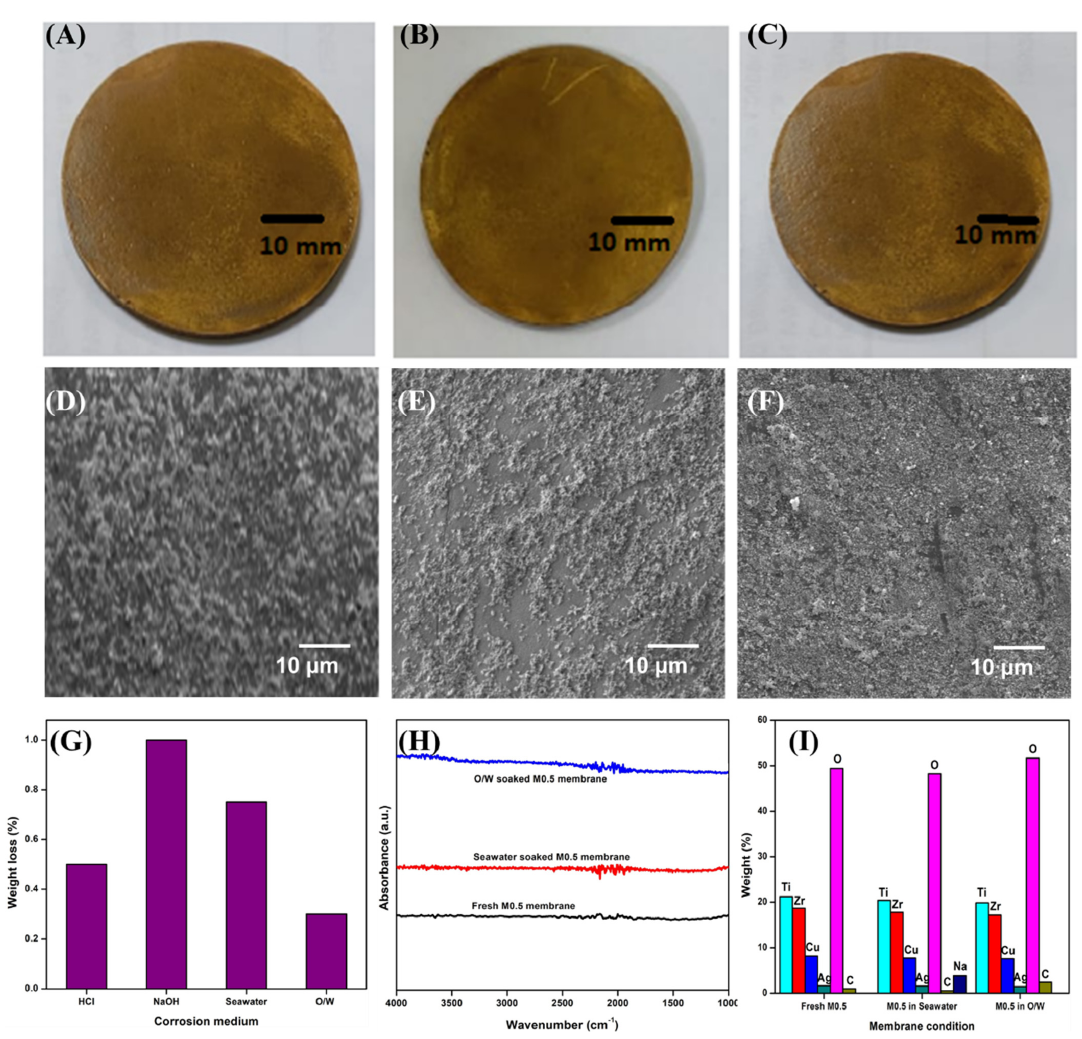
Figure 10. ( A ) Fresh M0.5 membrane ( B ) M0.5 after immersion in seawater for 72 h ( C ) M0.5 after immersion in o/w emulsion for 72 h; ( D – F ) SEM micrographs of fresh-seawater-soaked and o/w-emulsion-soaked M0.5 membrane; ( G ) Weight loss of M0.5 in different corrosion medium; ( H ) FT-IR spectra of the M0.5 membrane; ( I ) Chemical composition of M0.5 membrane